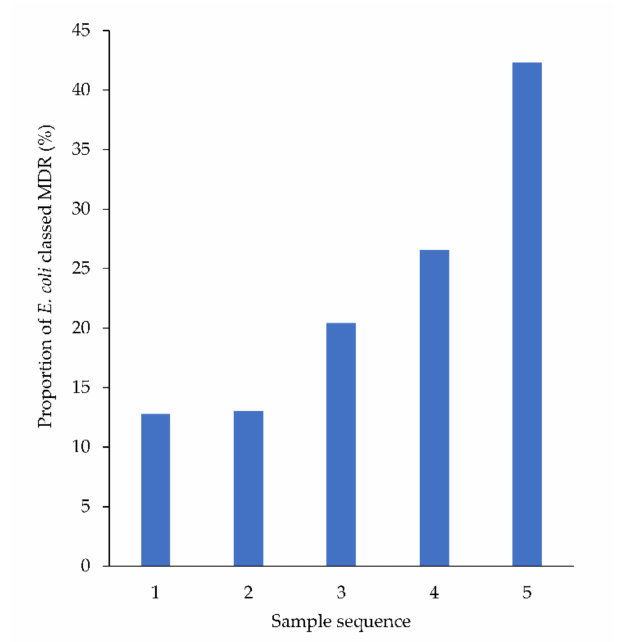
Figure 5. Proportion of E. coli (from animals from which ≥ 4 samples were cultured) classed as MDR, by sample sequence